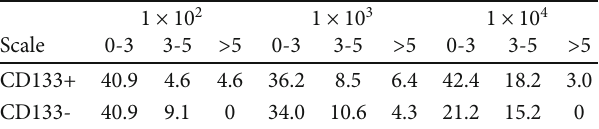
Figure 5: Tumor characteristic after end of follow-up: (a) average mass of tumors depending on the phenotype and number of implanted cells; (b) average values of necrosis areas in tumors depending on the phenotype and number of implanted cells; (c) average values of mitotic counts in tumors depending on the phenotype and number of implanted cells; (100+) — 1 × 10 2 B16-F10 cells expressing CD133 antigen implanted to mice; (100-) — 1 × 10 2 B16-F10 cells without expression of CD133 antigen implanted to mice. Table 1: Tumor mitotic index (%) evaluation depending on the phenotype and number of the examined